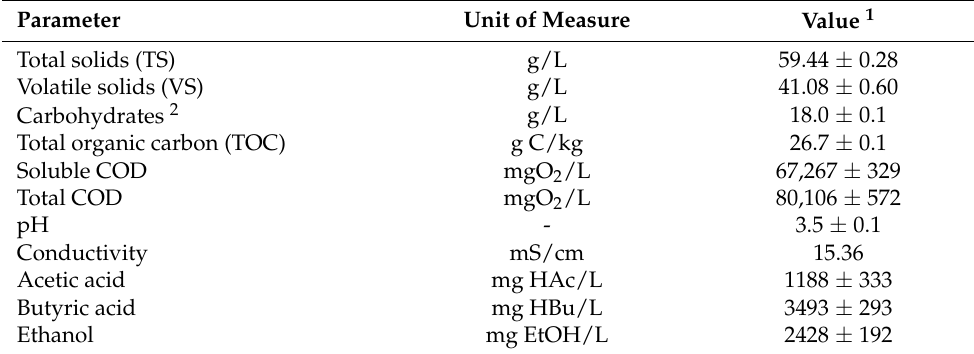
Table 2. Characterization of the IBH 2 S effluent used as the substrate for Stage 2.